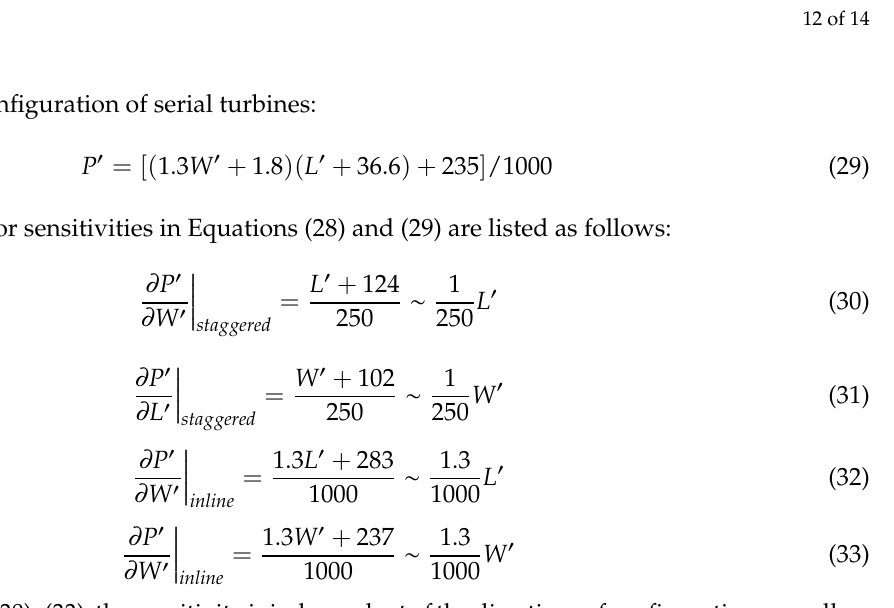
Figure 8. Computational domain of the two-low staggered model.